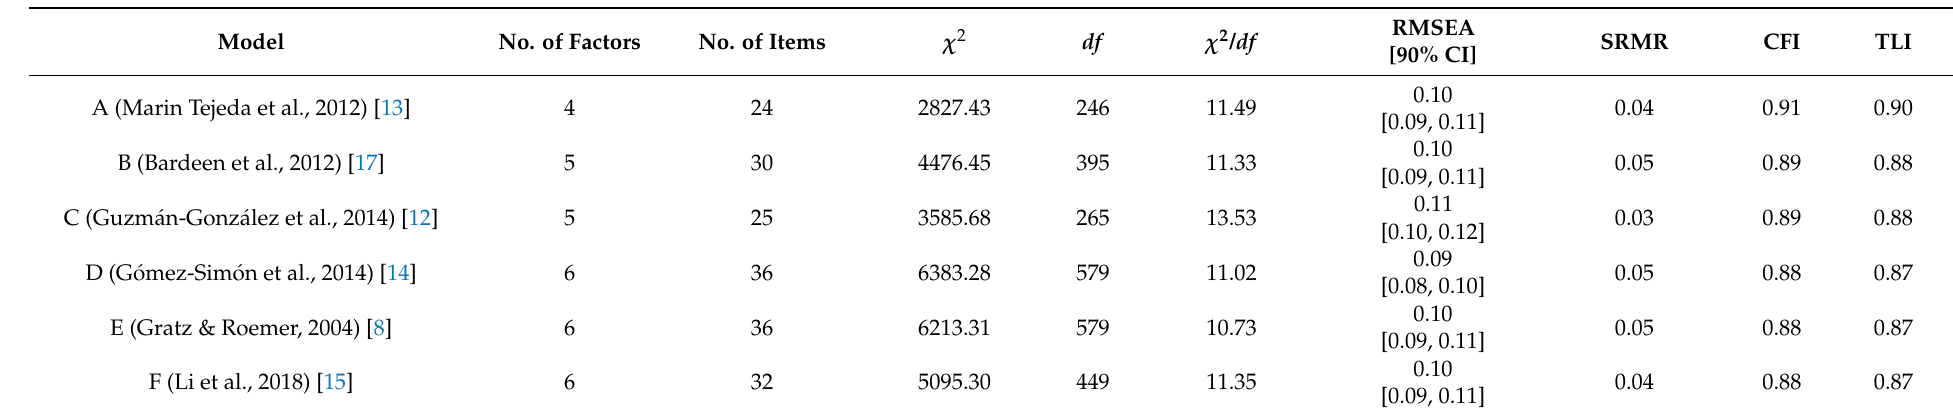
Table 3. CFA model-fit results of the existing structures of the DERS ( N =